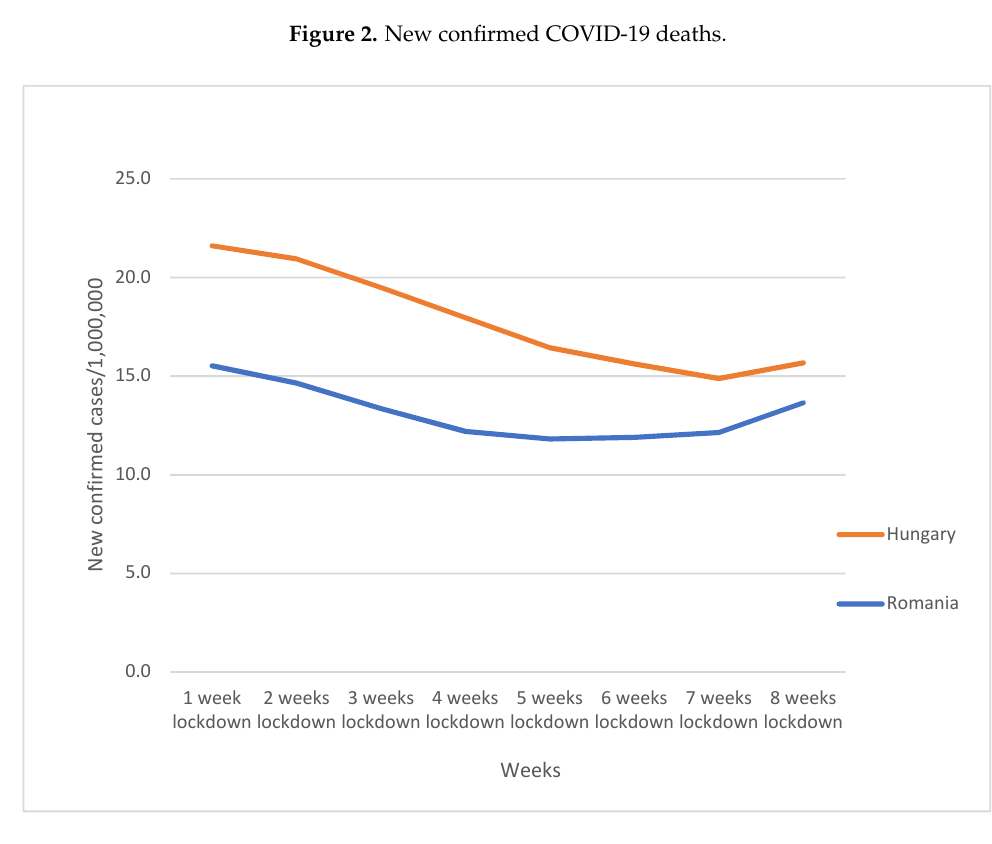
Figure 3. New confirmed cases/1,000,000.